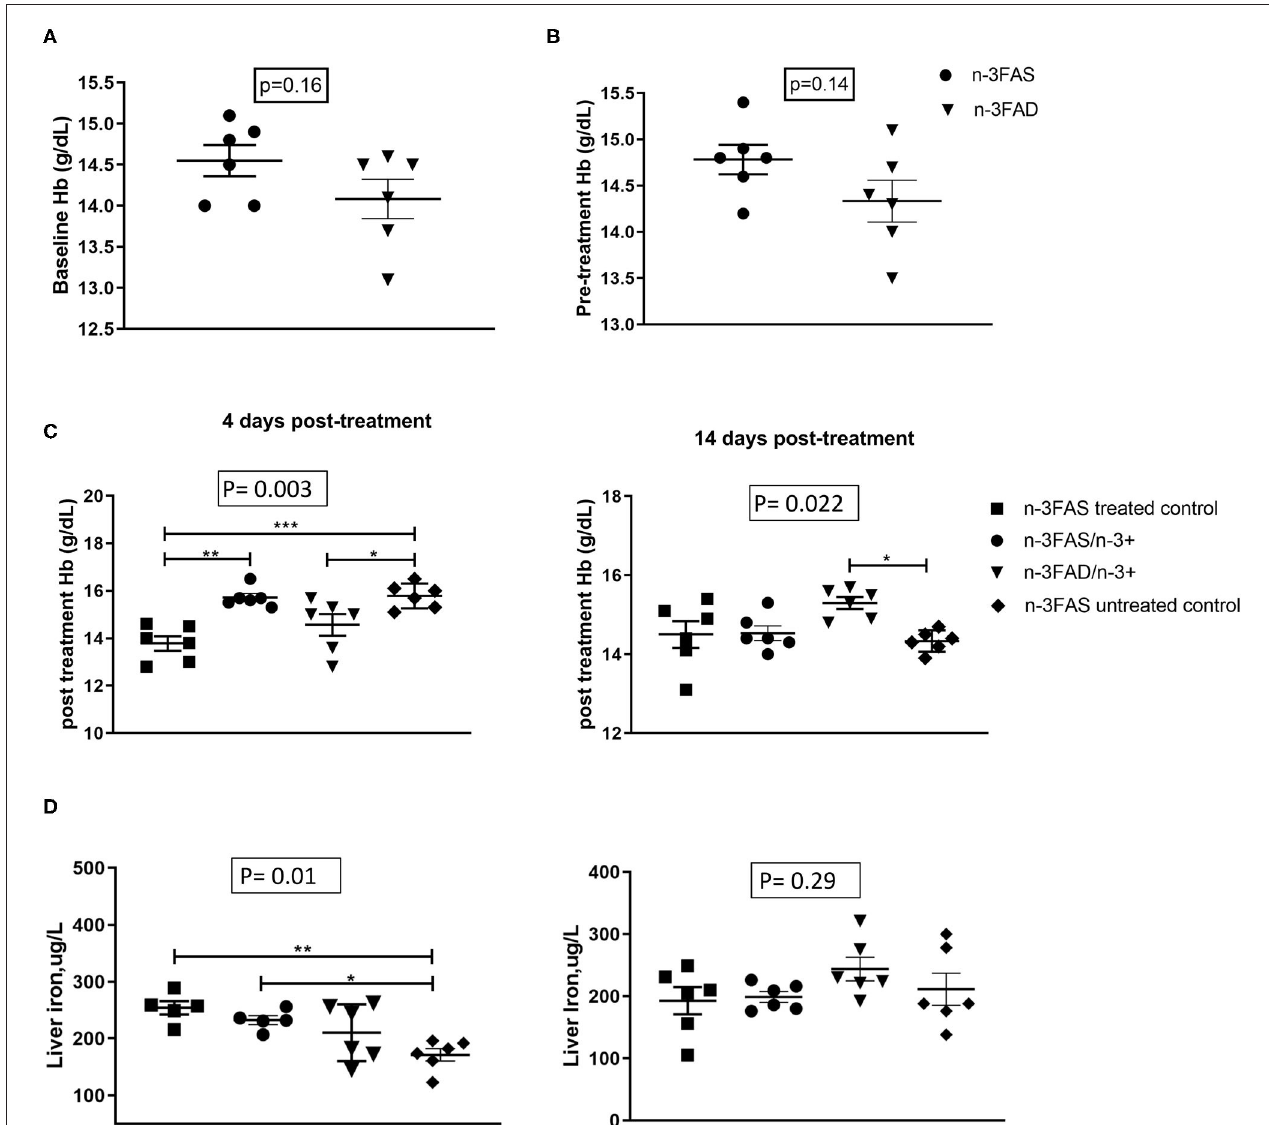
FIGURE 2 | Effect of status and n-3 long-chain polyunsaturated fatty acids (LCPUFA) supplementation on indices of anemia, (A) Baseline hemoglobin (Hb) levels, (B) Pretreatment Hb levels, (C) Posttreatment Hb levels, and (D) liver iron levels in liver homogenates. Baseline Hb levels were measured after 6 weeks of conditioning to either sufficient or low n-3 PUFA status. Pretreatment Hb levels measured after TB infection but prior to commencement of EPA/DHA supplementation. Posttreatment Hb levels were measured at each euthanasia time point after EPA/DHA supplementation. The data are represented as mean ± SEM of n = 6 mice/group and representative of two independent experiments. Independent t -tests were used to compare means, significance at * p < 0.05, ** p < 0.01, *** p < 0.001; n-3FAS, omega-3 fatty acid- sufficient diet group; n-3FAD, omega-3 fatty acid-deficient diet group; /, switched to; n-3FAS, omega-3 fatty acid-sufficient; n-3FAS/n-3 + , omega-3 fatty acid-sufficient group switched to DHA/EPA-enriched diet; n-3FAD/n-3 + , omega-3 fatty acid-deficient group switched to DHA/EPA-enriched diet; n-3FAS treated control, omega-3 fatty acid-sufficient group on only tuberculosis (TB) antibiotics treatment; n-3FAS untreated control, omega-3 fatty